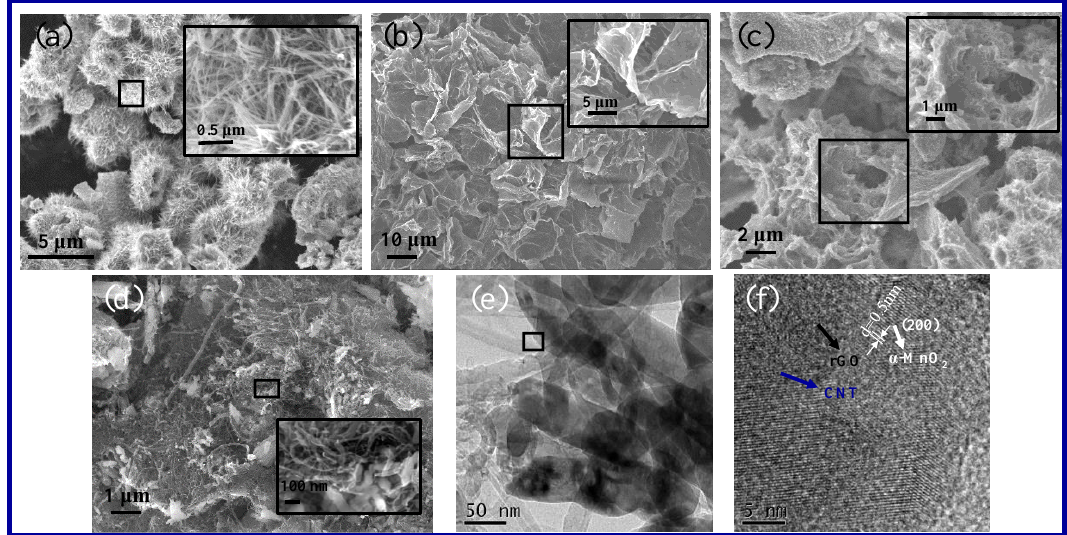
Figure 2. SEM images of MnO 2 ( a ), rGO ( b ), MnO 2 /rGO ( c ), and MnO 2 /rGO/CNTs ( d ), HRTEM images of MnO 2 /rGO/CNTs ( e, f ).